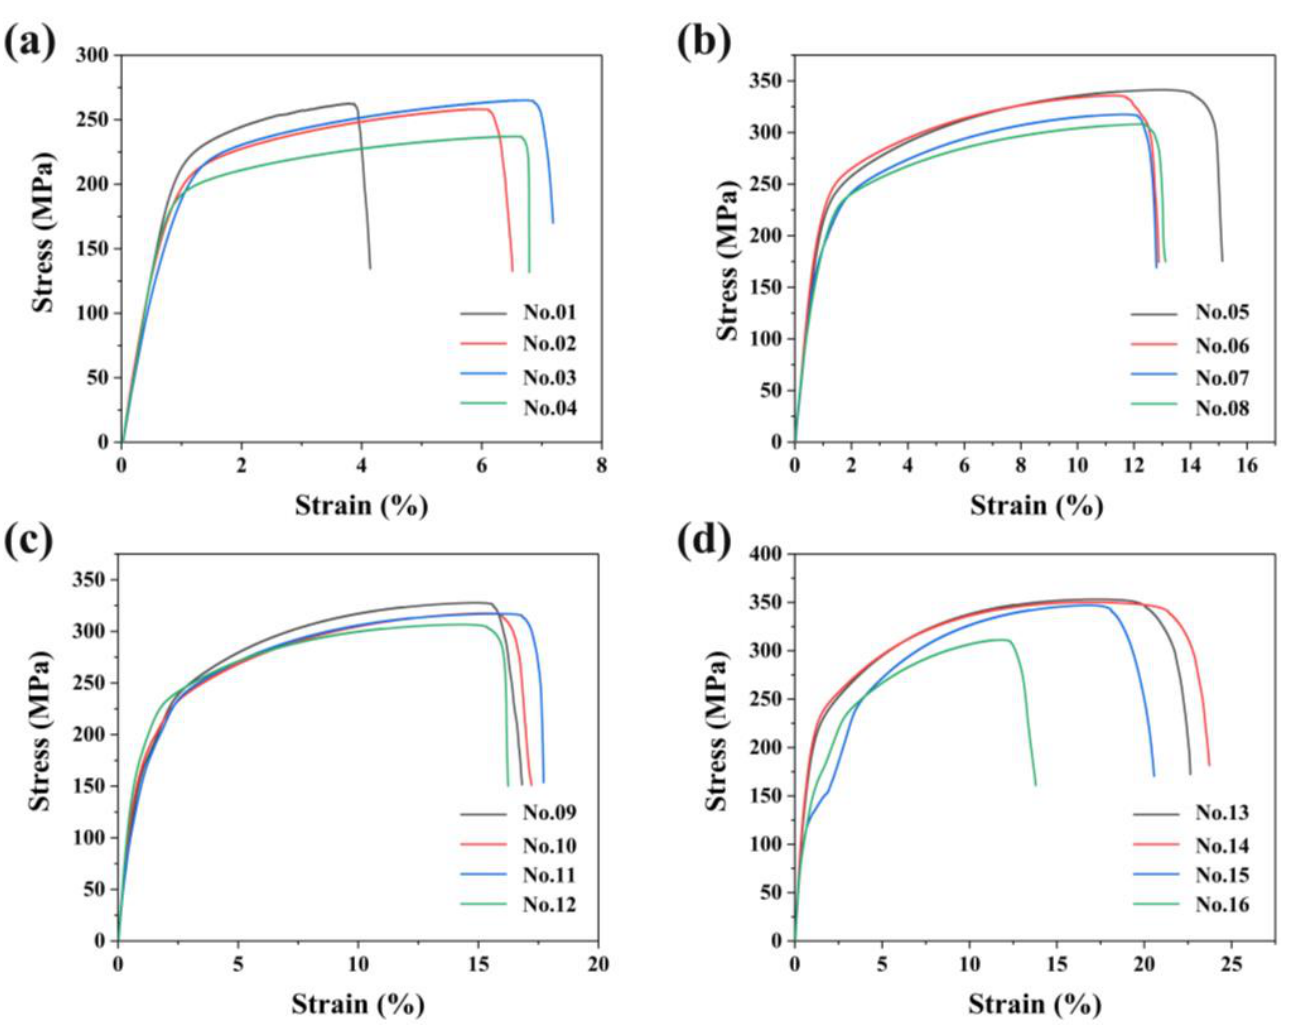
Figure 9. Stress – strain curve of CuCrZr alloy fabricated by SLM under different process Figure 9. Stress–strain curve of CuCrZr alloy fabricated by SLM under different process parameters. ( a ) Group A, ( b ) Group B, ( c ) Group C, ( d ) Group D.